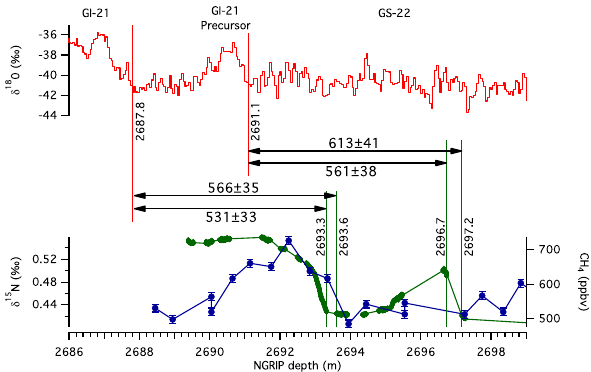
Fig. 4. Comparison of NorthGRIP ice core δ 18 O ice and trapped gas species for the determination of 1 age. δ 18 O ice is shown in red GICC05modelext chronology, Wolff et al., 2010) while δ 15 N is shown in blue (Capron et al., 2010b) and CH 4 concentration is shown in green (this study). Horizontal numbers indicate age dif- ferences between ice (red) and gas (green) transitions, while ver- tical numbers specify the depths assigned to temperature and gas features.